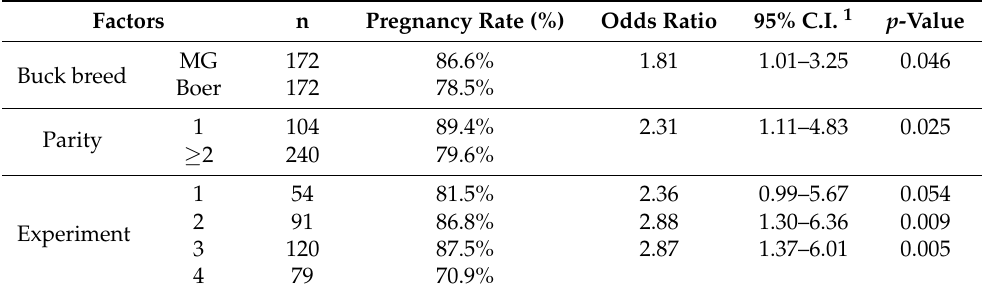
Table 4. Means and odds ratios of the factors included in the final logistic regression model for kidding rate in Murciano-Granadina (MG) goats (primiparous and multiparous) mated with Boer bucks (n = 12) or MG bucks (n = 12) in 4 experiments. Factors N Kidding Rate (%) Odds Ratio 95% C.I. 1